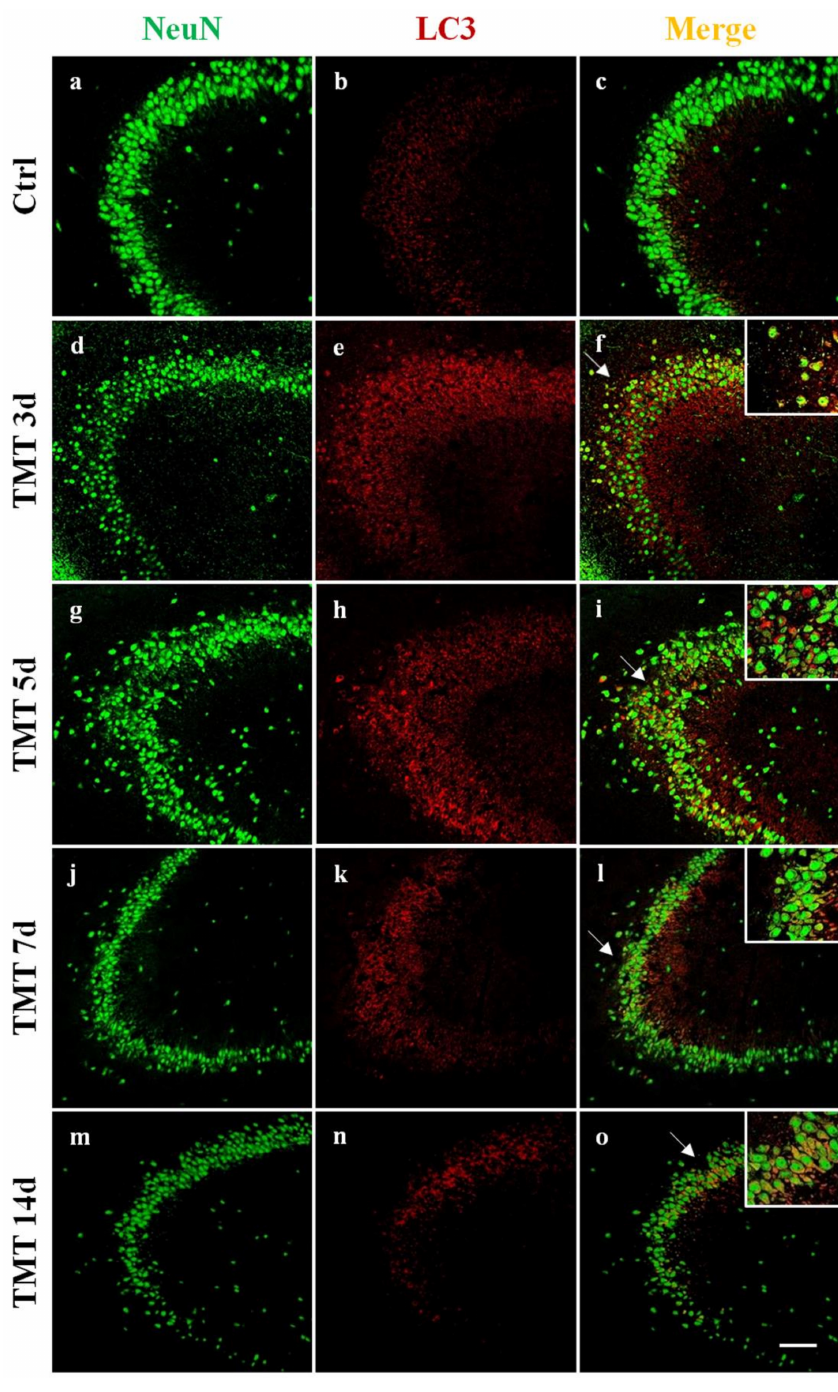
Figure 3. Localization and expression of LC3 in the rat hippocampal neurons, after TMT treatment, in the CA3 area are shown. Sections of the CA3 field at di ff erent intoxication time-points (3, 5, 7, and 14 days) are labeled for Neu N (green, a , d , g , j , m ), LC3 (red, b , e , h , k , n ), and Neu N / LC3 (merge, c , f , i , l , o ). Control sections ( a – c ). At 3 days after treatment, marked LC3 immunoreactivity was observed ( e ) and LC3 labeling strongly increased at 5 days ( h ). LC3 staining decreased at 7 ( k ) and 14 days ( n ) post intoxication. Note the progressive loss of Neu N-positive neurons in TMT-treated rats ( d , g , j , m ) compared with control rats ( a ). Arrows and inserts show details. Scale bar: 100 µ m. Ctrl: control sample, d: days. For interpretation of the references to color in this figure legend, the reader is referred to the Web version of this